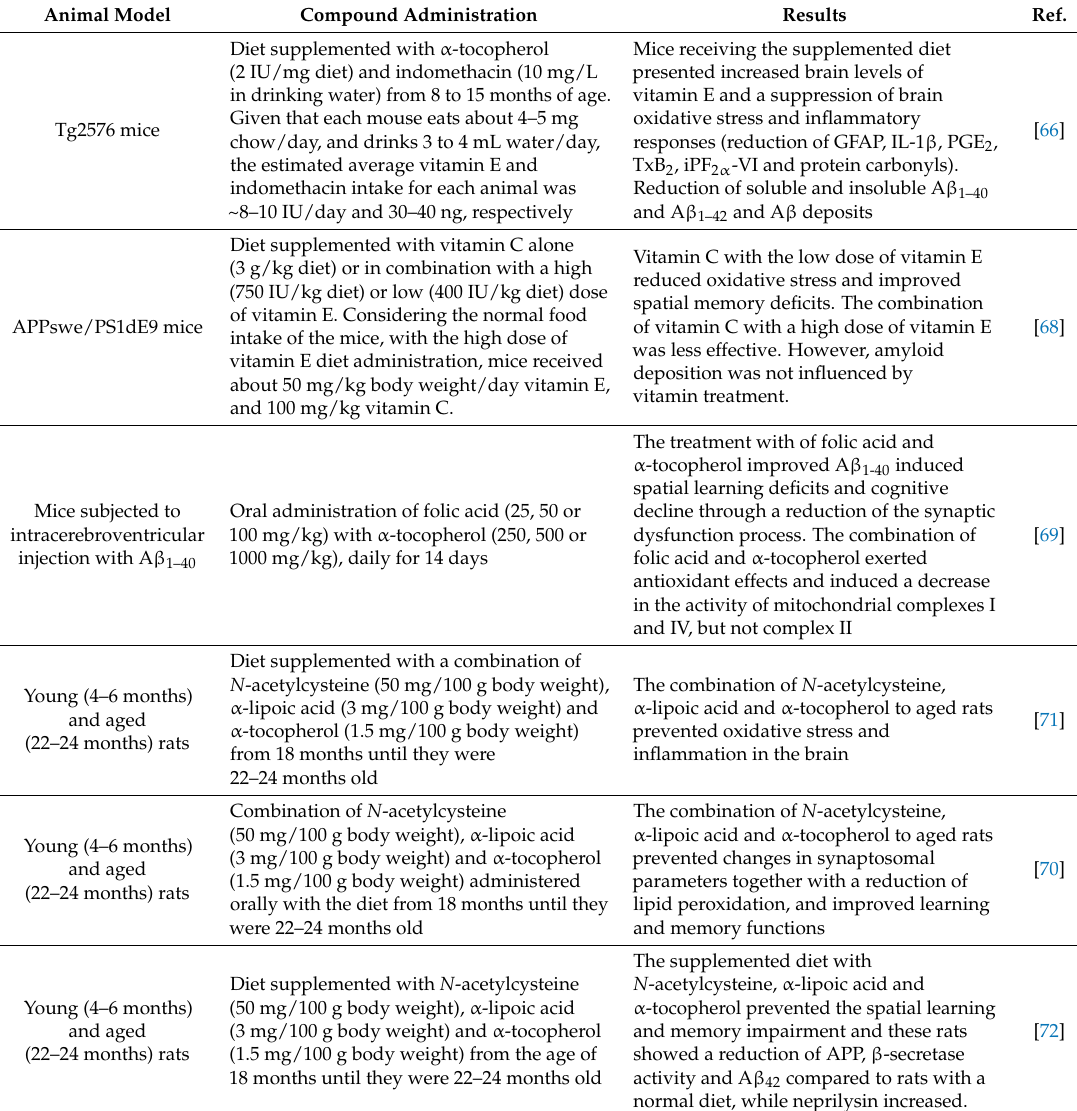
Table 2. Experimental studies evaluating vitamin E supplementation together with other